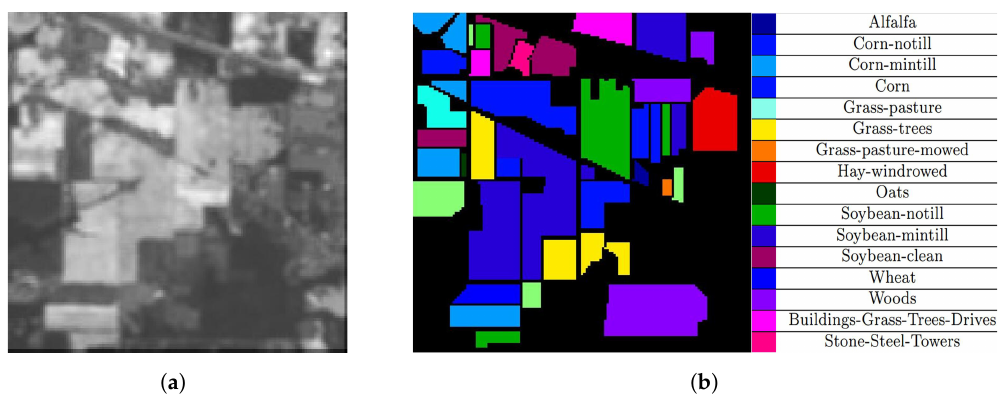
Figure 4. ( a ) The gray image and ( b ) the corresponding ground truth map of Indian dataset.